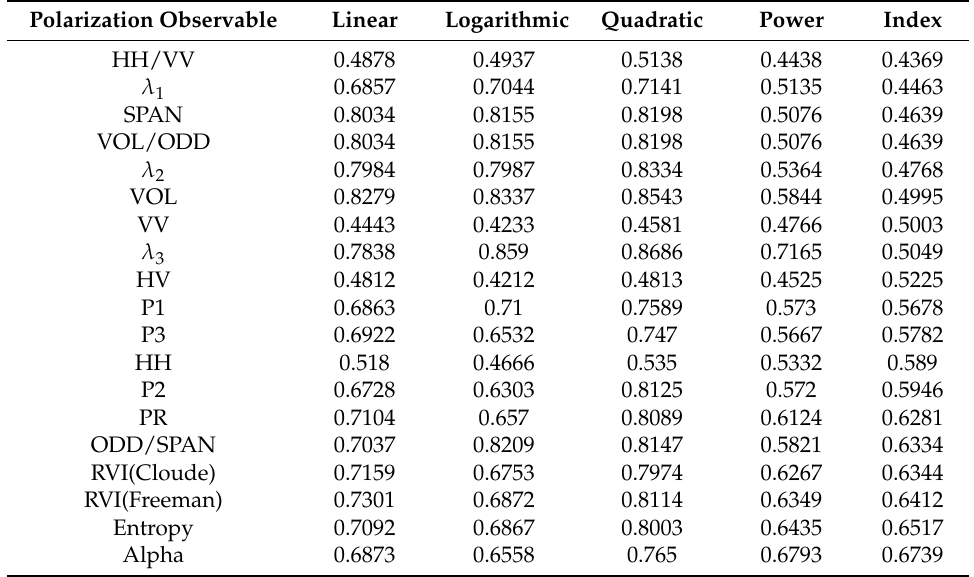
Table 4. Coefficients of determination (r 2 ) of five empirical regression models for biomass